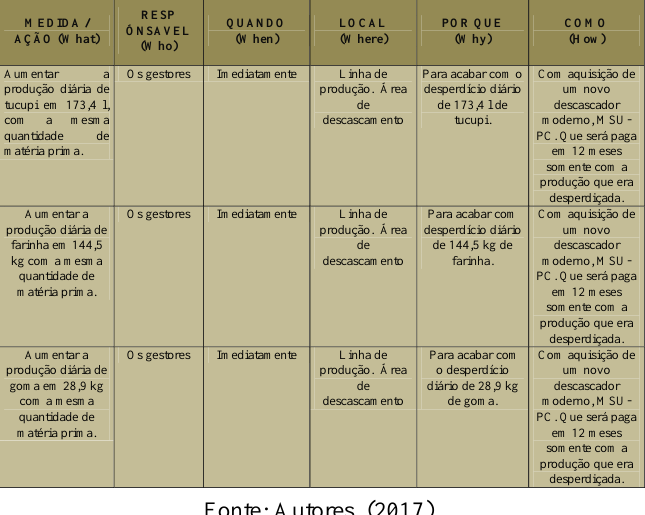
Tabela 11: Matriz GUT para as Principais